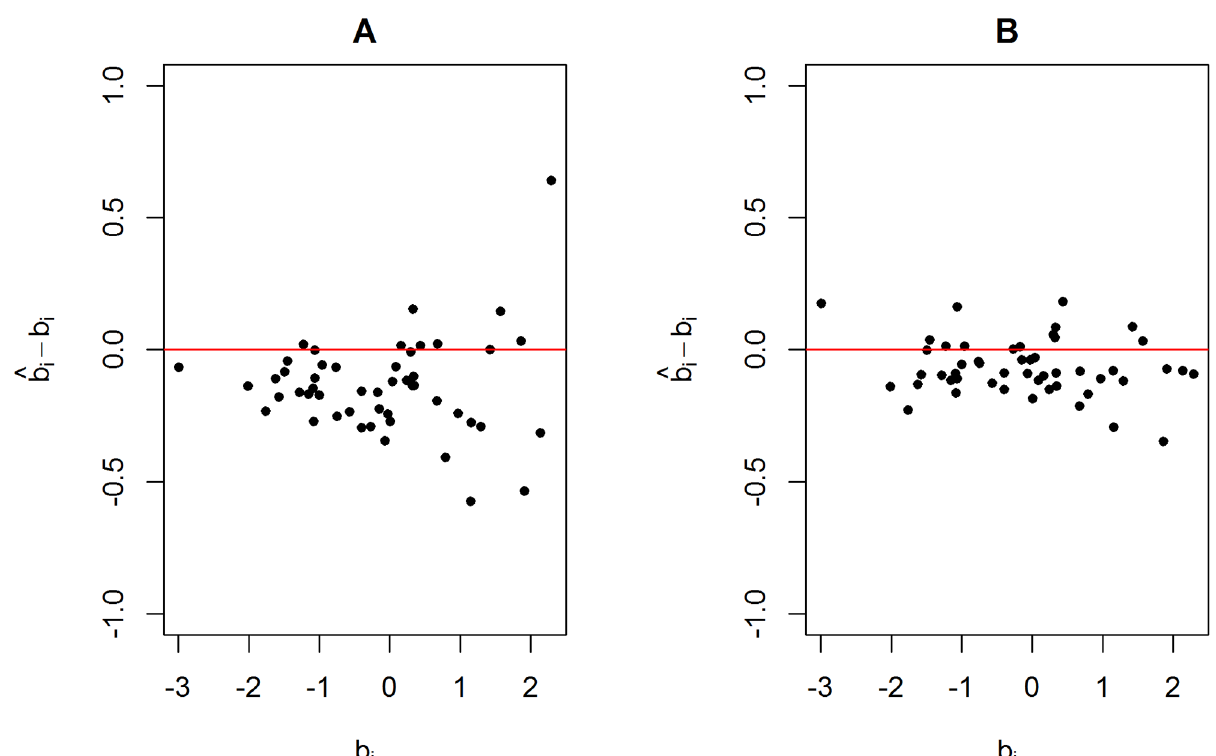
Fig 6. Scatter plot using data generated from scenario 2 with a weight value equal to 10. The differences between estimated and true item difficulties are plotted against the true item difficulties. (A) Estimated values using the standard Rasch model. (B) Estimated values obtained using the proposed